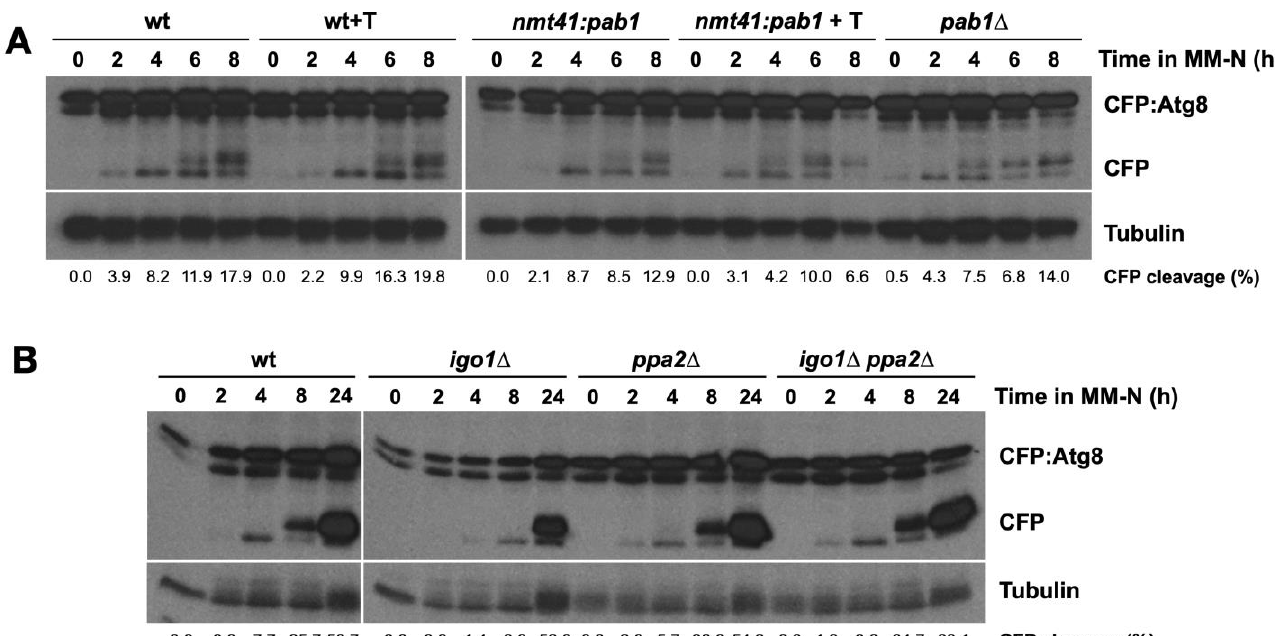
Figure 8. PP2A/B55 negatively regulates nitrogen starvation-induced autophagy. ( A ) Wild type, nmt41:pab1 + cells, grown in minimal medium with (+T) or without thiamine at 25 ◦ C, and pab1 ∆ cells grown until mid-exponential phase were transferred to nitrogen-free minimal medium (MM-N) for 8 h at 25 ◦ C. Samples were collected at 0, 2, 4, 6, and 8 h in MM-N. CFP:Atg8 and free CFP levels were determined using anti-GFP antibodies (Clontech). Tubulin was used as a loading control. ( B ) Wild type, igo1 ∆ , ppa2 ∆ , and igo1 ∆ ppa2 ∆ cells grown in minimal medium at 25 ◦ C until mid-exponential phase were transferred to nitrogen-free minimal medium (MM-N) for 24 h at 25 ◦ C. Samples were collected at 0, 2, 4, 8, and 24 h in MM-N. CFP:Atg8 and free CFP levels were determined using anti-GFP antibodies (Clontech). Tubulin was used as a loading control. The percentage of CFP cleavage is indicated under the